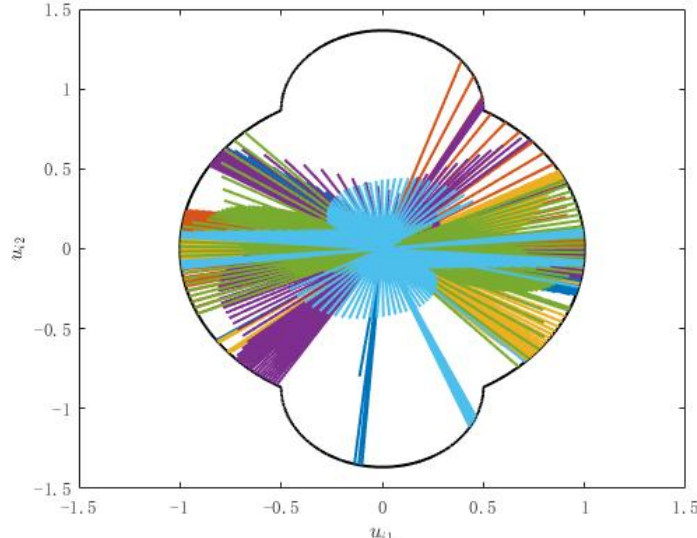
Figure 5. Control input u i ( k ) of followers.